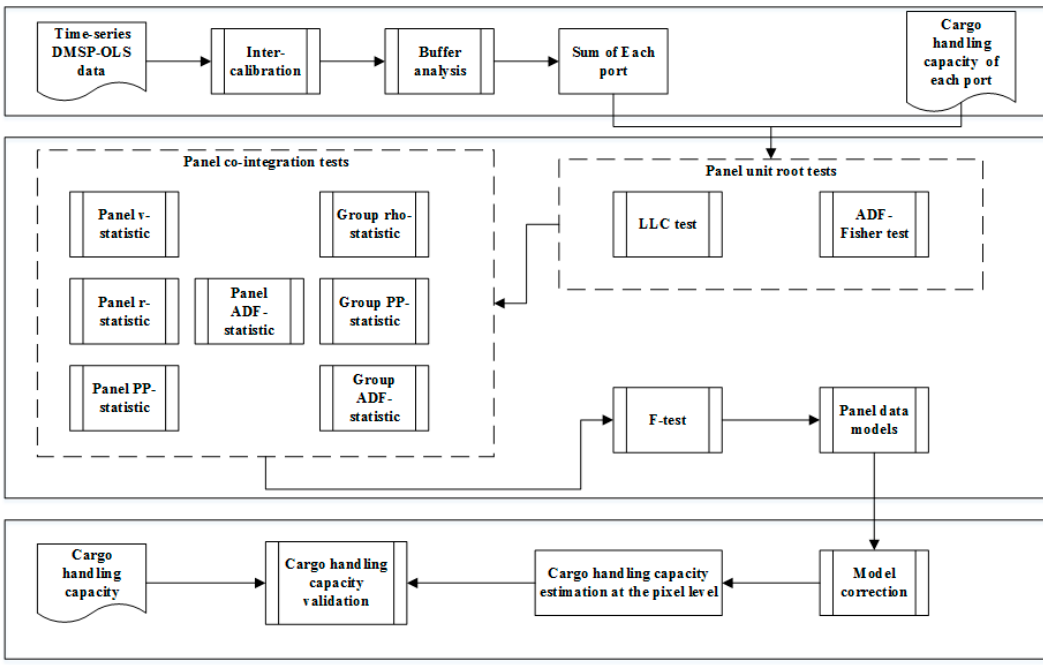
Figure 5. Research process flow chart.